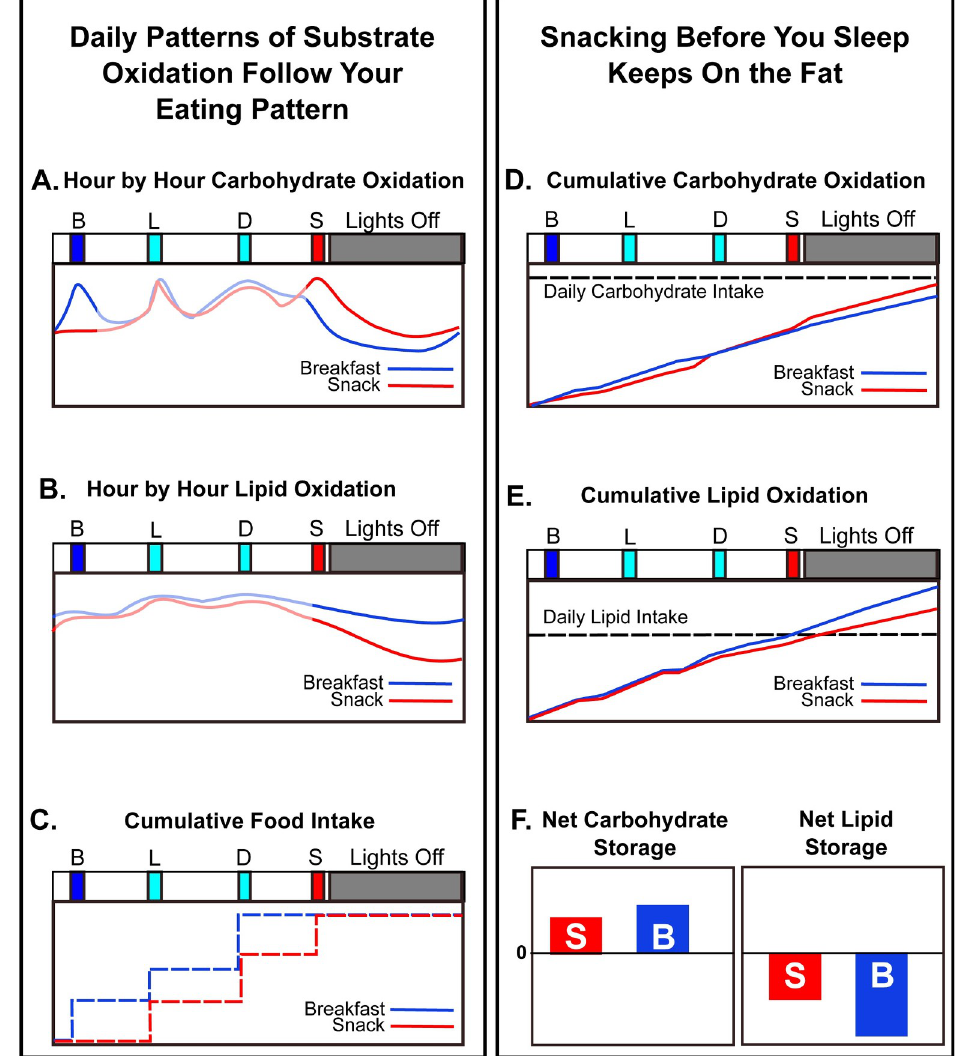
Fig 4. Schematic: Late-evening snacking interacts with the circadian rhythm of metabolism to inhibit LO. (A and B) Hour-by-hour oxidation rates for carbohydrates (panel A) and lipids (panel B) in the two sessions. These curves are smoothed versions of the experimental data in Fig 3. (C) Cumulative food intake on the Breakfast versus Snack Sessions. (D and E) Cumulative oxidation rates over the 24-h cycle derived from the curves in panels A and B and the experimental data of Fig 3. Panel D shows cumulative CO, while panel E shows cumulative LO. The horizontal dashed lines indicate the daily total intake of carbohydrates (D) and lipids (E) for comparison with the cumulative respective oxidations. (F) Approximate net relative daily storage of carbohydrates and lipids inferred from the data of Fig 3 and the analyses depicted in the other panels of this figure (arbitrary units). Positive values indicate the extent of substrate accumulation/storage, and negative values indicate the extent of substrate oxidation ("burning"). CO, carbohydrate oxidation; LO, lipid oxidation.